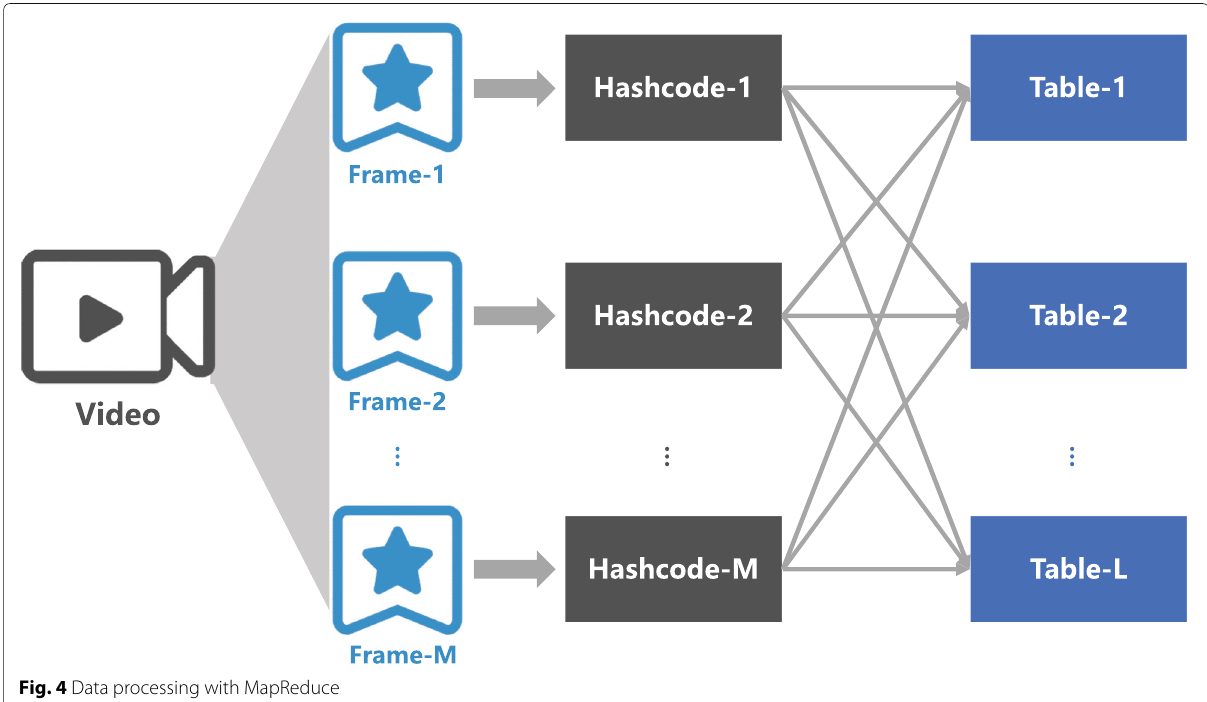
Fig. 4 Data processing with MapReduce